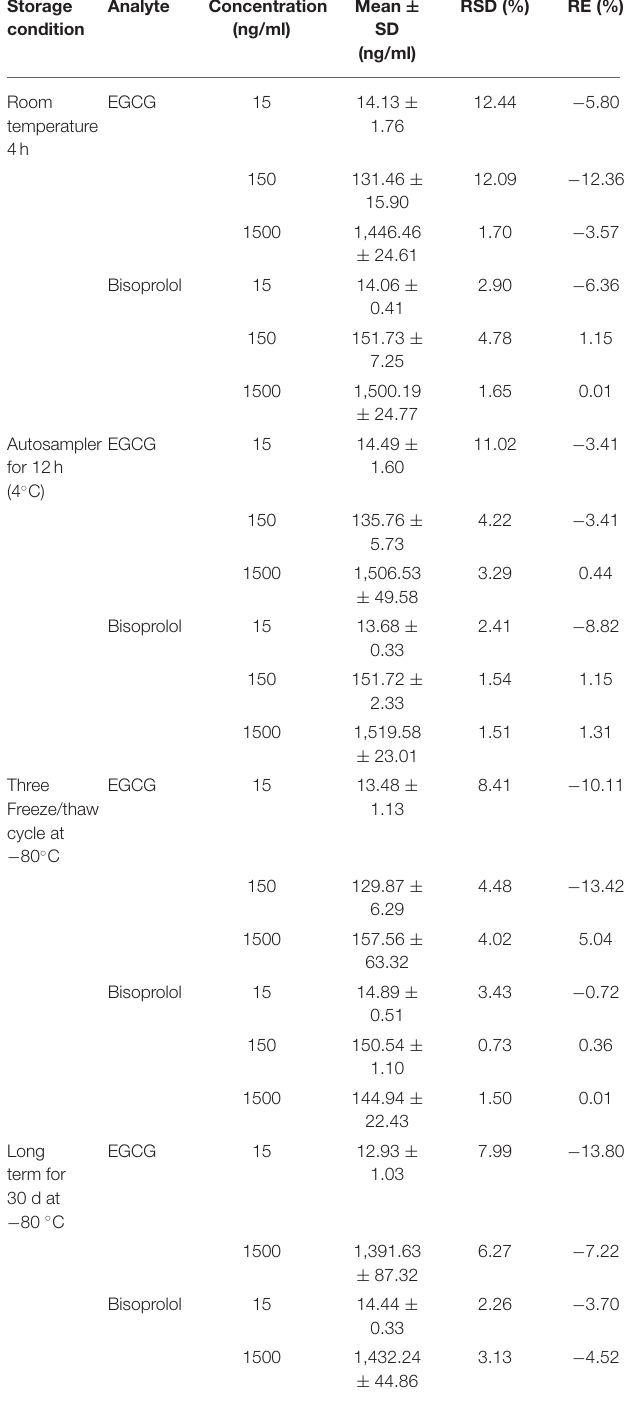
TABLE 4 | Stability of EGCG and Bisoprolol in plasma (mean ± SD, n = 6). Storage Analyte condition